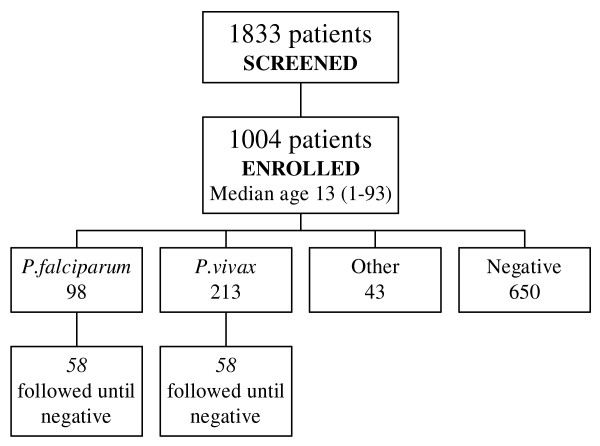
Patient flow diagram. Note: 'Other 'includes mixed infections and slides with either malaria pigment or gametocytes only. One subject <2 years enrolled (protocol violation).